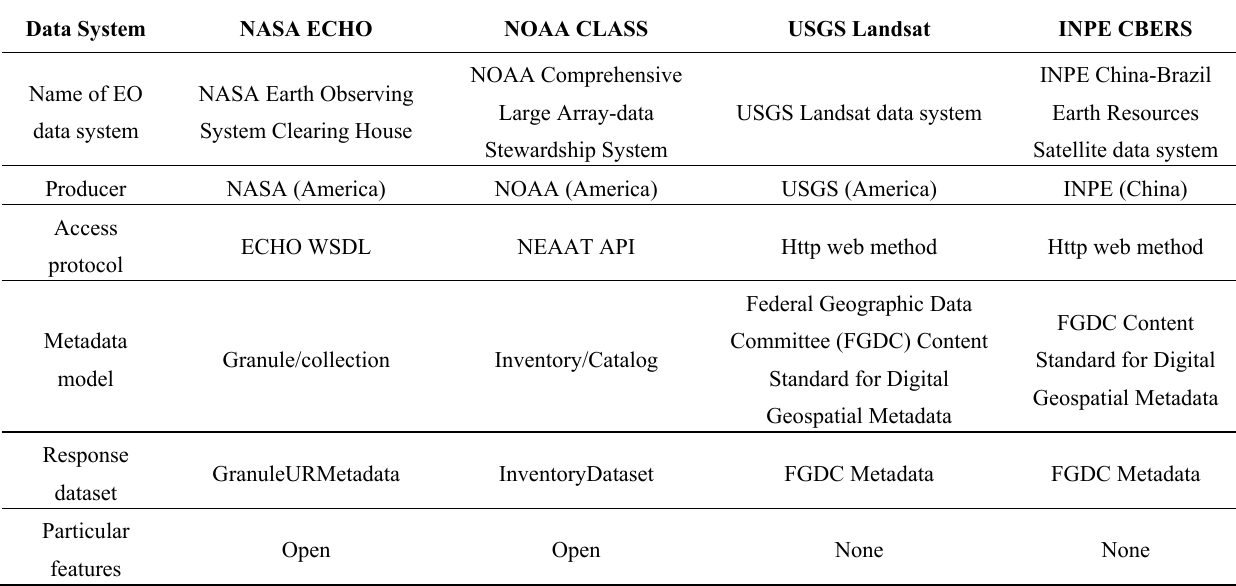
Table 1. Analysis of typical EO data systems. ECHO, Earth Observing System Clearing House; WSDL, Web Services Definition Language; NEAAT, Web Services Definition